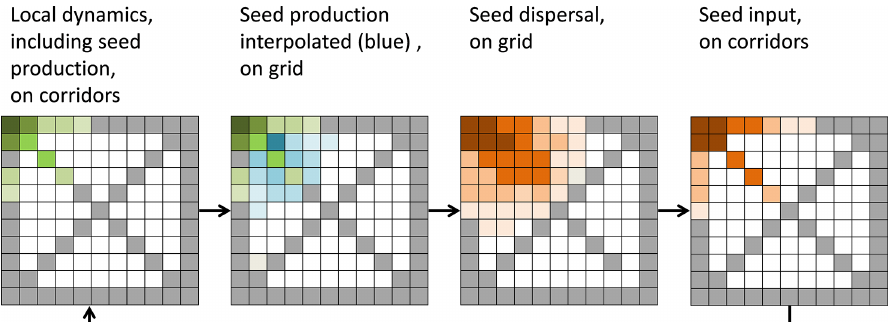
Figure 3. Example of a simulated grid with transects (grey). In each time step the local vegetation dynamics, including the seed production (green), is calculated on the transects. Then the seed production of each species is interpolated from the transects to all non-transect grid cells (blue) and then dispersed on the entire grid (brown). The seed input on the transect cell then enters the local dynamics in the next time